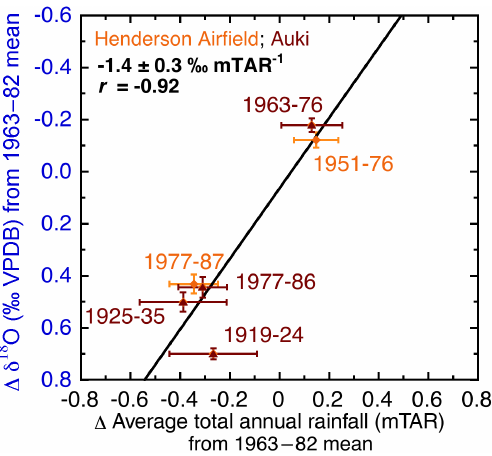
Figure 7. Plot of stalagmite δ 18 O versus total annual rainfall from local rain gauge data. Means and standard errors were calculated for rain gauge and stalagmite δ 18 O records during contemporane- ous intervals within individual known PDV phases, when data exist for both time series. Labels indicate the interval over which means and standard errors were calculated. Means for each of the three re- spective time series over the only time interval in which all three overlap, 1963–1982, were removed from respective values in order to standardize the cross plot to account for the difference in total rainfall amount at Auki and Henderson